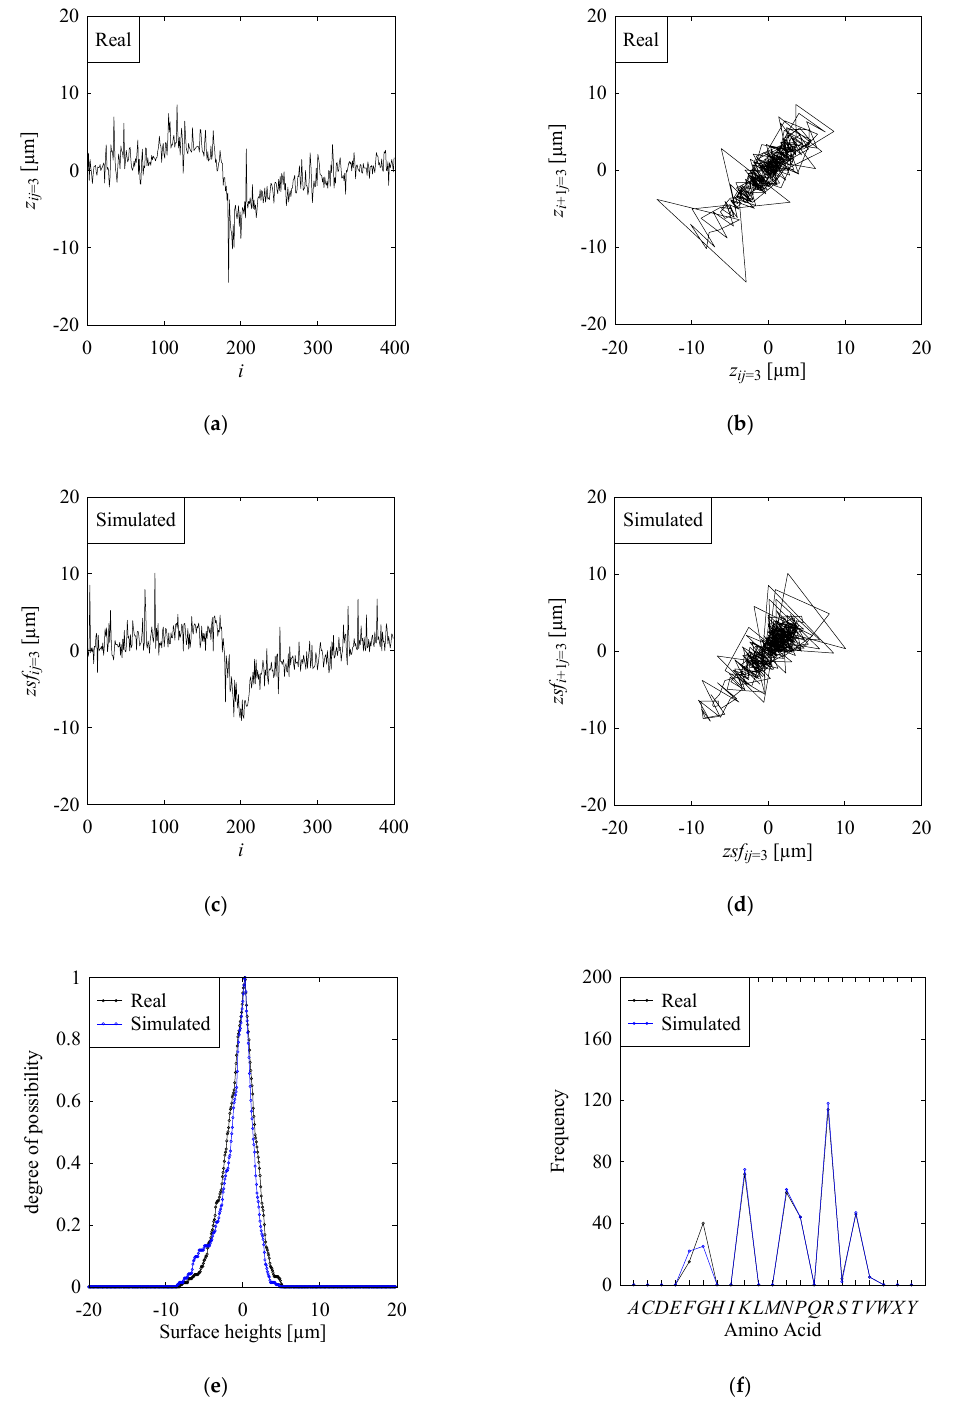
Figure A3. Outcomes of SC and VC corresponding to the semantic modeling-based MC for z ij =3 : ( a ) real surface heights; ( b ) return map of ( a ); ( c ) simulated surface heights; ( d ) return map of ( c ); ( e ) possibility distribution; ( f ) DNA-based computing.